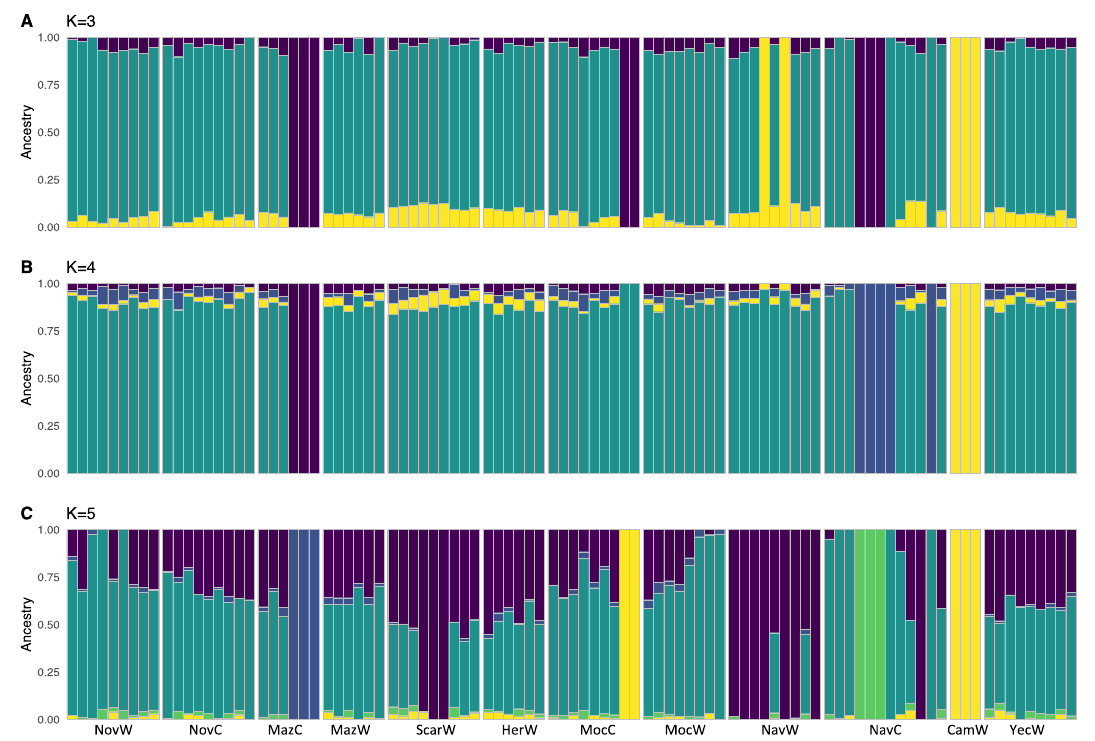
Figure 1. Clustering solutions obtained with 95 wild and cultivated individuals of Agave angustifolia var. pacifica from the state of Sonora, Mexico. Values of K from 3 to 5 are shown. In each plot ( A – C ), each cluster is represented by a different color, and each individual is represented by a vertical line divided into K colored segments with heights proportional to genotype memberships in the clusters. Thin white lines separate individuals from different regions and management types as coded in Table S1 (e.g., NovW corresponds to the Novillo region and wild samples, whereas MazC corresponds to the Mazatan region and cultivated samples).